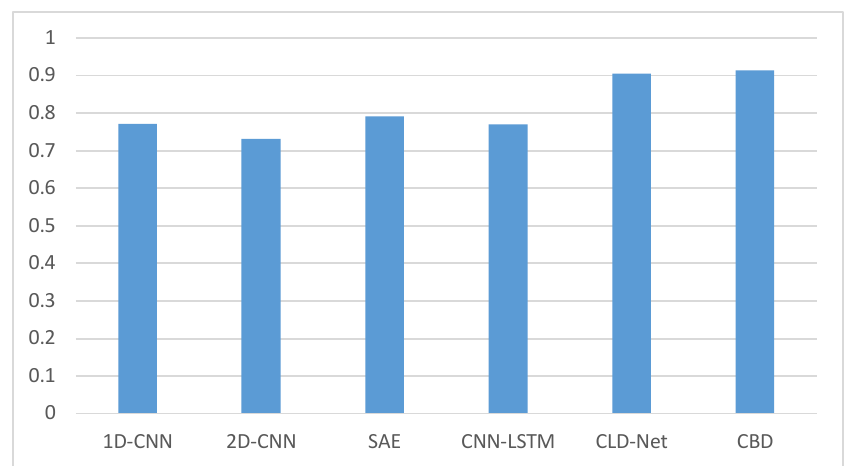
Figure 9. Accuracy comparison results of several models when the sample size is